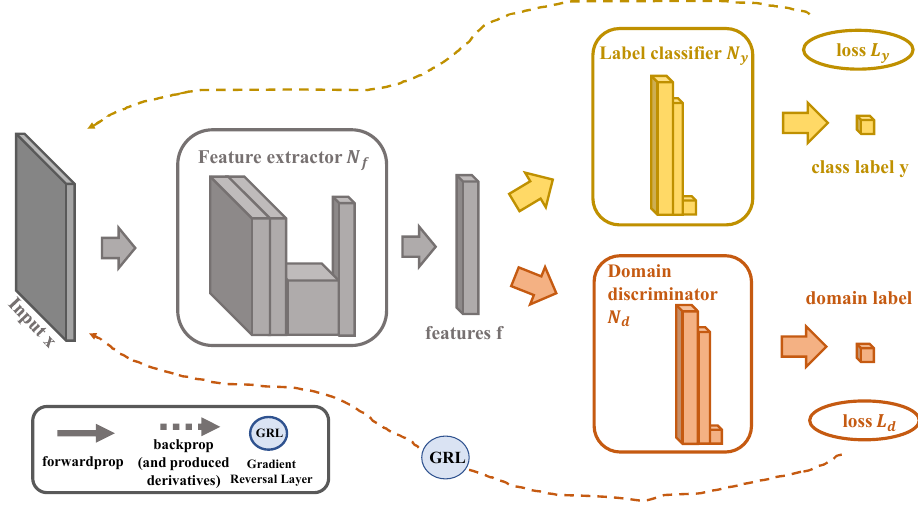
Figure 3. The Architecture of Domain-Adversarial Neural Network (DANN). (DANN combines three networks ( N f , N y , and N d ) to align data from different distributions of source and target